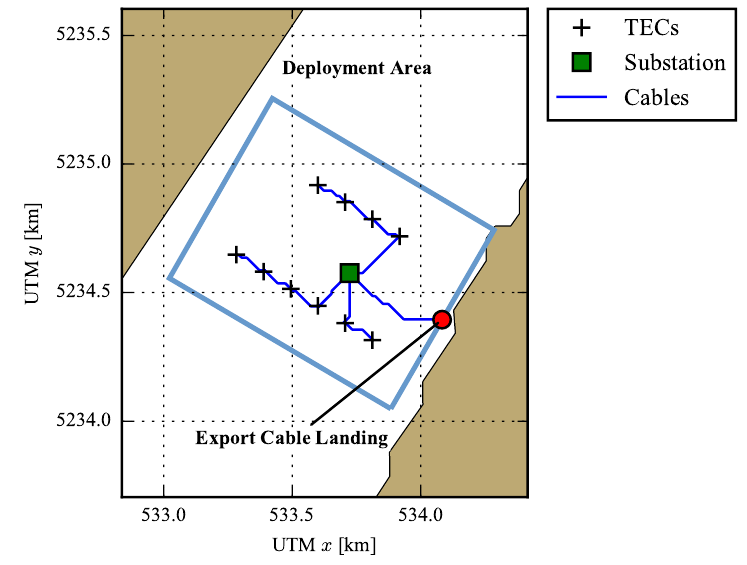
Figure 13. 10 TEC DTOcean simulation array layout and electrical